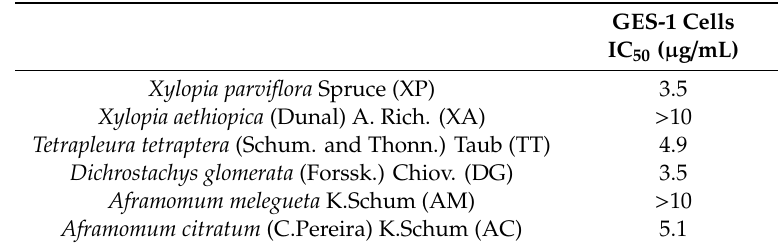
Table 3. Half-maximal Inhibitory Concentration (IC 50 ) ( µ g / mL) of the extracts on the IL-6 release in gastric epithelial (GES-1)